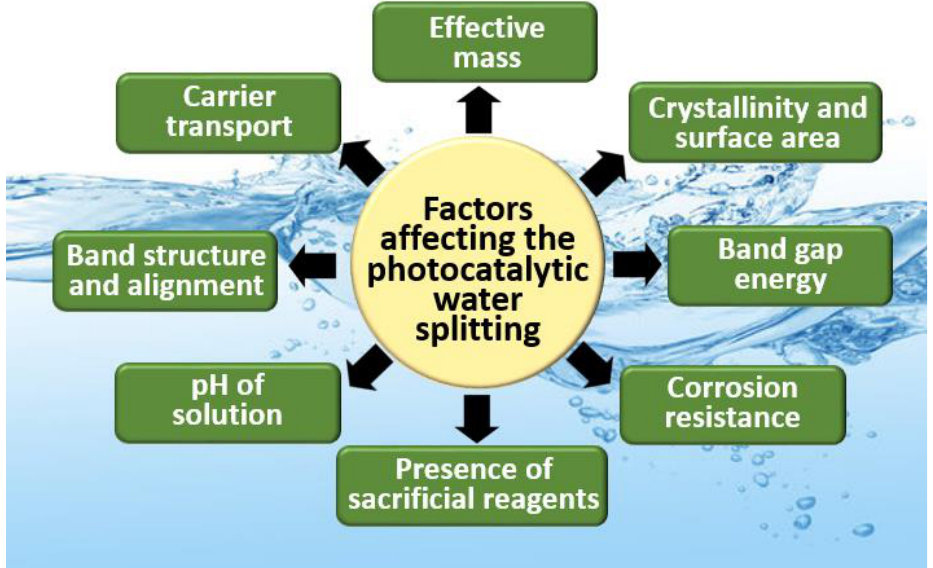
Figure 2. Factors affecting the photocatalytic water-splitting process.